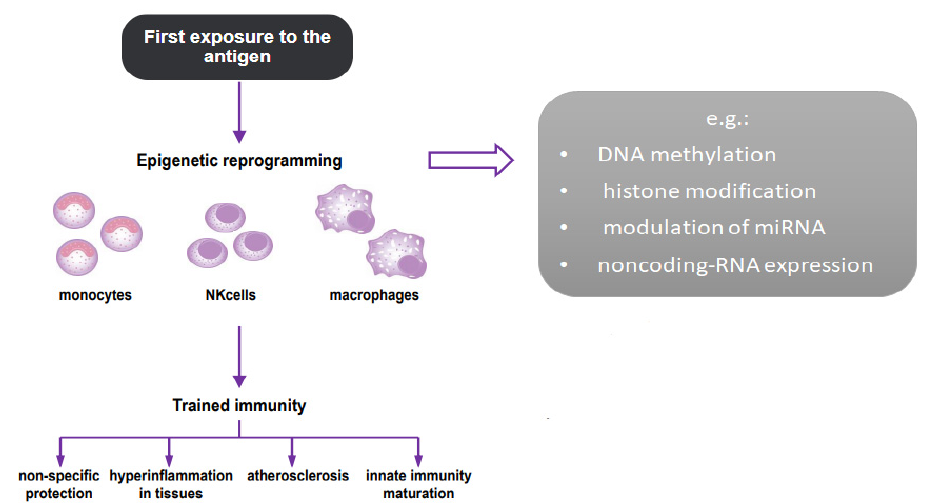
Figure 1. The trained immunity mechanism. The figure was created based on an article by Netea et al. [16].